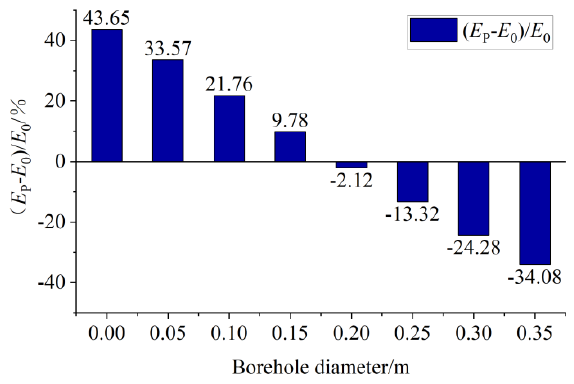
Figure 7. ( E P − E 0 )/ E 0 of boreholes.